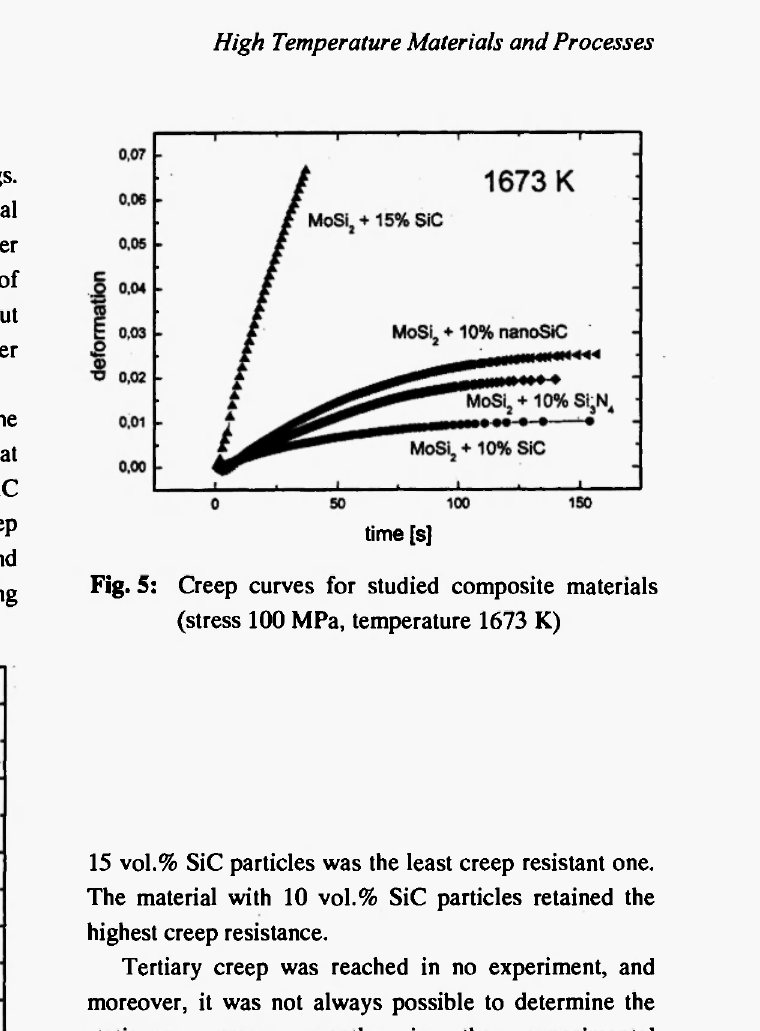
Fig. 3: Creep curves for studied composite materials (stress 100 MPa, temperature 1273 K)